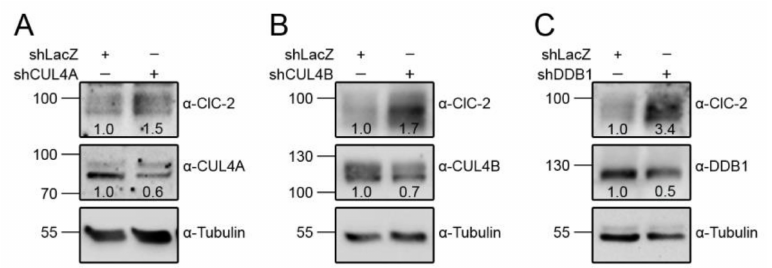
Figure 8. CUL4 and DDB1 promote the degradation of endogenous ClC-2. Representative immunoblots showing the e ff ect of shRNA knockdown of CUL4A (shCUL4A) ( A ), CUL4B (shCUL4B) ( B ), or DDB1 (shCDDB1) ( C ) on endogenous ClC-2 expression in MA-10 cells. Infection with shLacZ was used as the control experiment. The numbers on the immunoblot denote the relative ClC-2 protein levels.